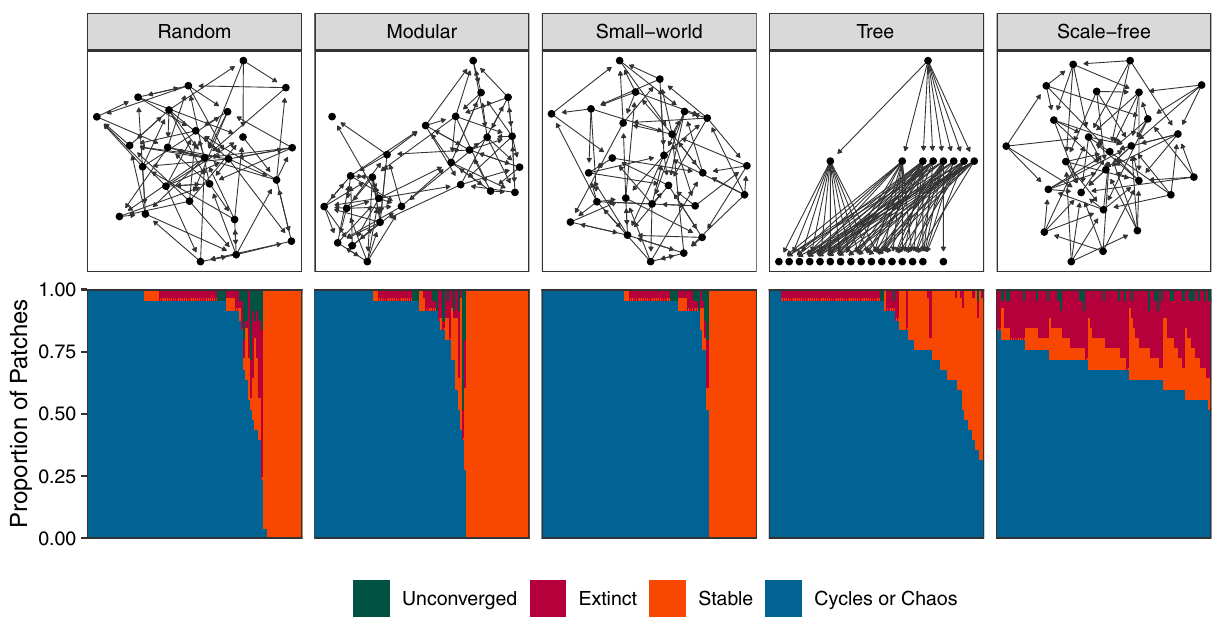
Figure 4. The proportion of patches exhibiting each dynamical regime in each of 100 random networks per network structure ensemble. Each panel shows stacked bar charts, with networks lined up along the horizontal axis, sorted according to the proportion of patches exhibiting oscillatory dynamics. Each bar is colored according to the equilibrium dynamical regime of each of the 25 patches per network. “Extinct” indicates a disease-free equilibrium for that patch, “Stable” indicates a constant prevalence through time, and “Cycles or Chaos” indicates that the prevalence fluctuates through time. “Unconverged” indicates patch dynamics that could not be classified within the timescale of the simulation. For example, looking at the tree networks, every patch in the left-most network exhibited oscillatory dynamics, while the right most network had 18 ( ≈ 75% ) patches exhibiting “Stable” dynamics. Networks were generated according to one of five algorithms (see Methods). Similar results are obtained with alternative parameter values (Supporting Information Fig.